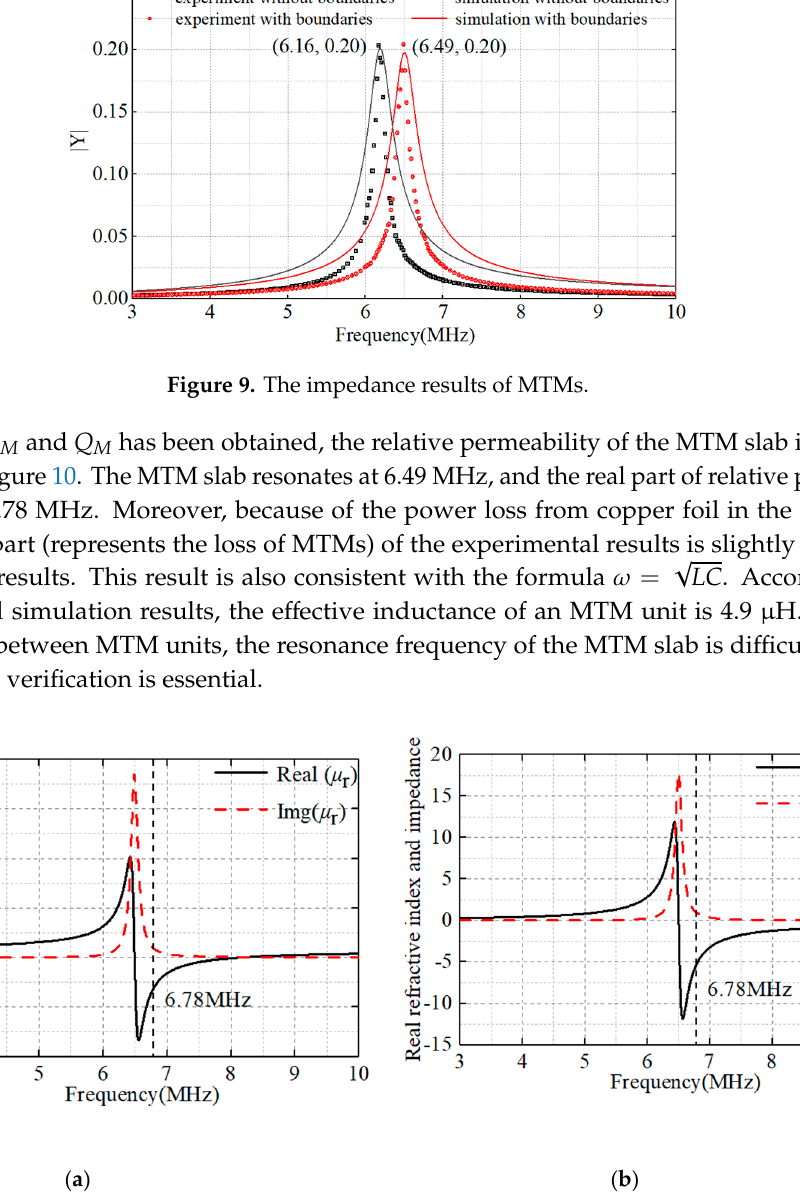
Figure 10. The relative permeability of the experimental MTM slab. ( a ) The experimental results. ( b ) The simulation results.